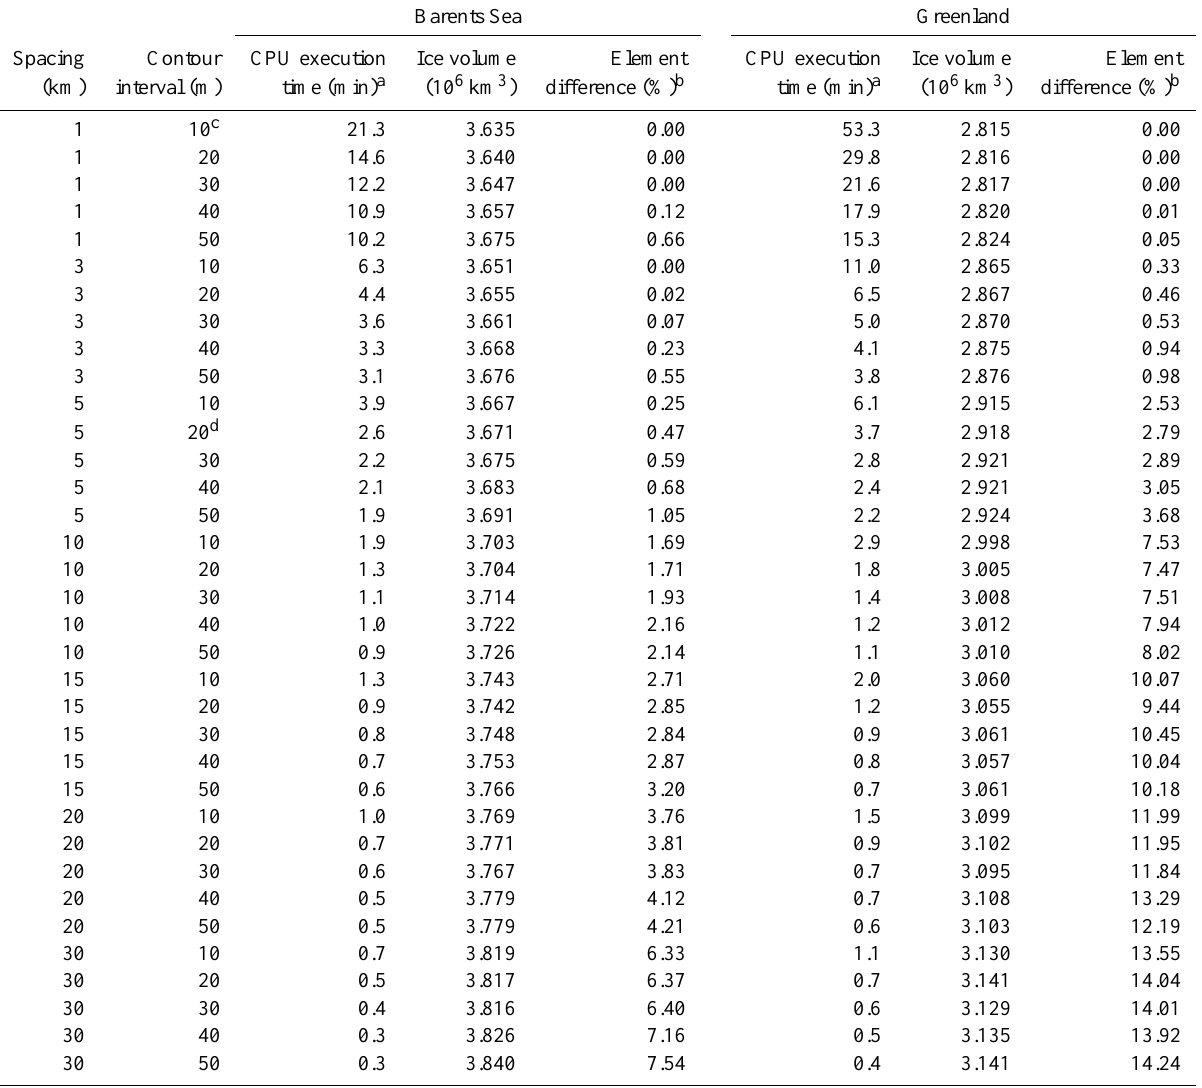
Table 1. Results of the resolution test Barents Sea